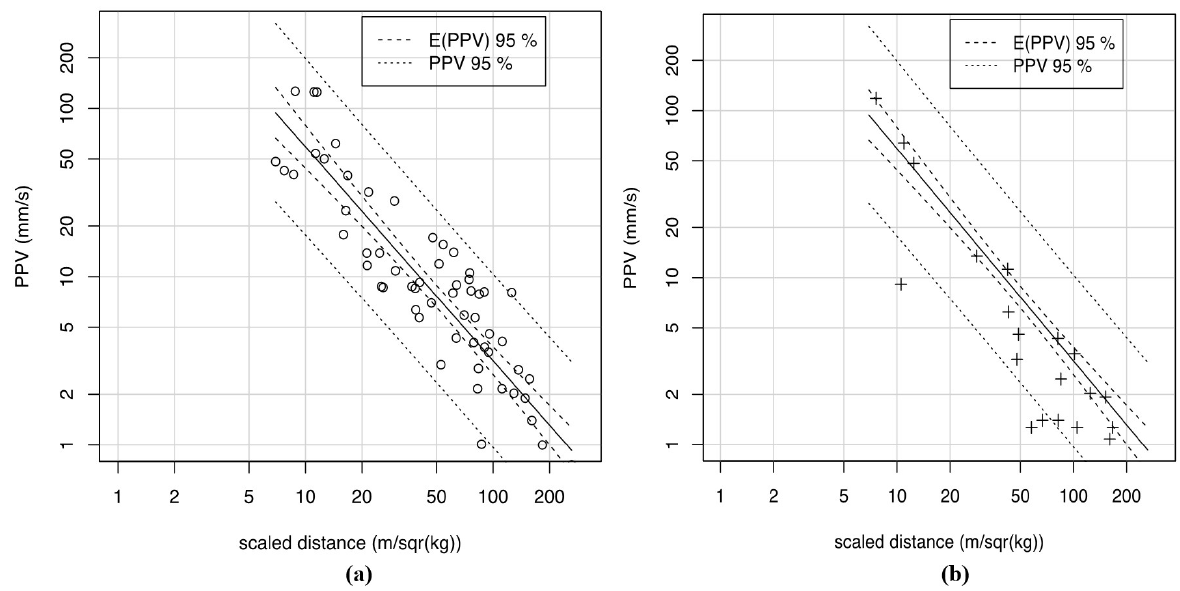
Figure 7: (a) Least squares regression and 95% confidence level curves with the used trial blasts; (b) Observed production blasts and 95% confidence level curves.